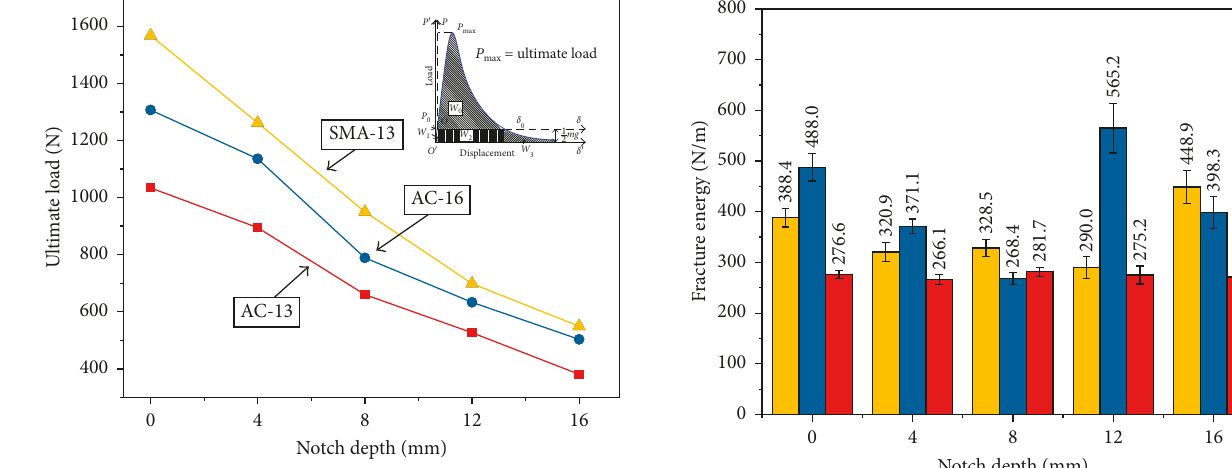
Figure 6: Ultimate loads for different notch